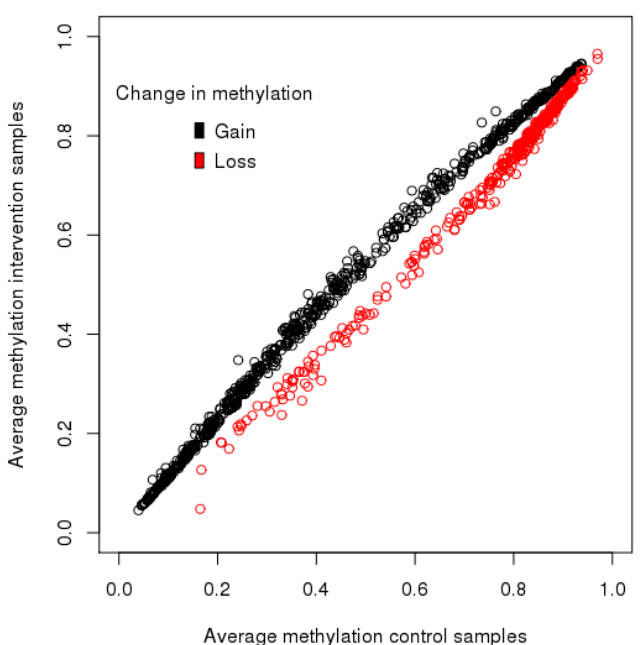
Figure 2. Scatter plot of the average methylation of the top 1000 di ff erentially methylated CpG sites and the change in methylation between the intervention and control groups.